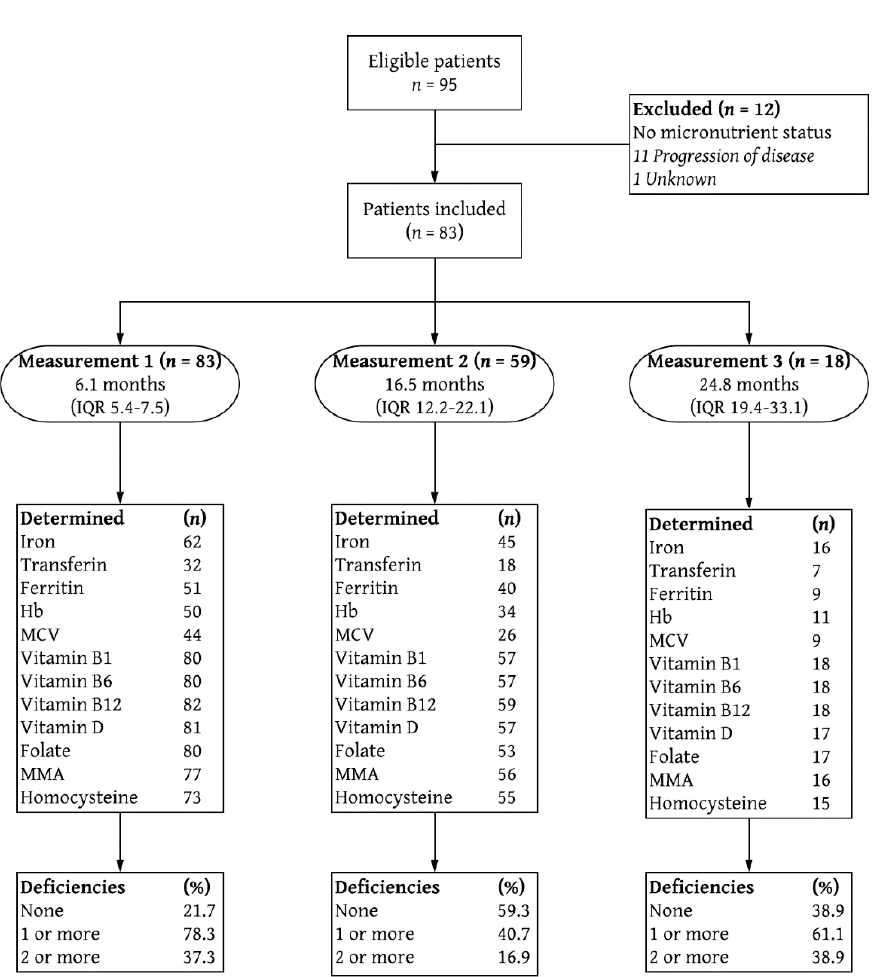
Figure 1. Flowchart depicting study inclusion and follow-up measurements. Deficiencies are % of total. IQR interquartile range; Hb hemoglobin; MCV mean corpuscular volume; MMA methylmalonic acid.